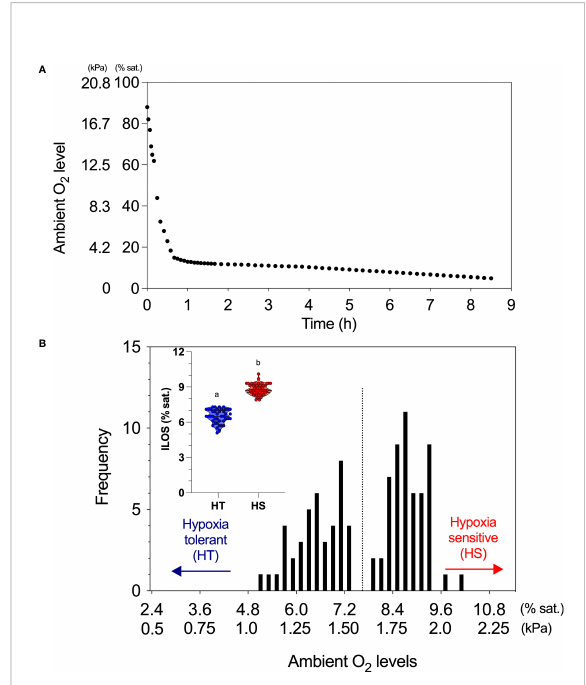
FIGURE 1 A demonstration of the results from a typical hypoxia challenge test (HCT) that quanti fi es the frequency distribution of the hypoxia tolerance trait in a population of fi sh. (A) The test reduces the ambient water oxygen (O 2 ) level (% saturation (sat.) or kPa) in the testing arena at an initially fast and then slower rate ( see details in the methods). The fast phase minimizes the possibility of a rapid acclimation response to hypoxia. The slow phase makes it easier to remove and identify the individual fi sh when they lose their upright equilibrium and provides for a more reliable resolution of the hypoxic tolerance trait, their incipient lethal oxygen saturation (ILOS). (B) The resultant frequency distribution of ILOS for a population of European sea bass ( Dicentrarchus labrax ) at 16.5°C, which revealed a bimodal distribution for hypoxia tolerance with no individual between 7.40% sat. and 8.25% sat. (1.5 – 1.7 kPa) (adapted from Zhang et al., 2017). Hence, this population of European sea bass (n = 96) had a near equal proportion of hypoxia tolerant individuals (HT; n = 42) and hypoxia-sensitive individuals (HS; n = 54). These two hypoxic tolerance traits re fl ect the important intraspeci fi c variation. The insert (violin plot: dash line = median, dotted line = quantile) shows the modality (independent t-test) for ILOS between the HT and HS